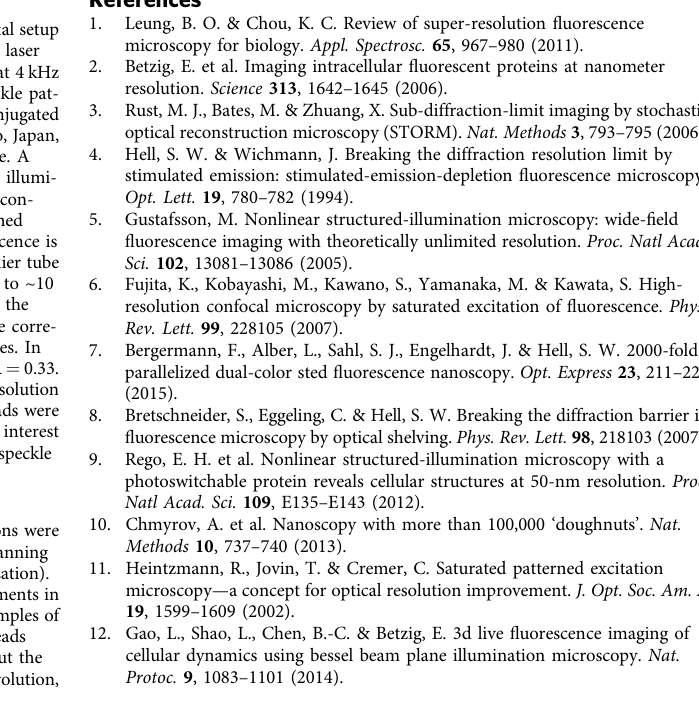
step size t . For optimal reconstruction, the step size t is maintained as small as possible (10 − 7 ) and λ is varied between 0 and 1; 0 is optimal for least sparse objects and 1 for most sparse objects. The optimization is done by comparing the root mean squared error a posteriori on reconstructions using different parameters. Object reconstruction by FISTA typically took from roughly 4 – 6min (371.58s for 170 × 170 ×25-voxels data and 226.54 s for 150 × 150 ×25-voxels data),